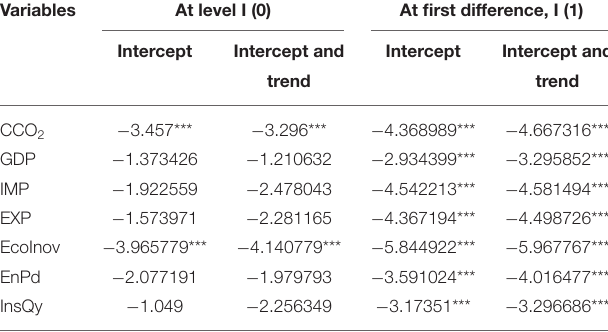
TABLE 4 | Unit root test.